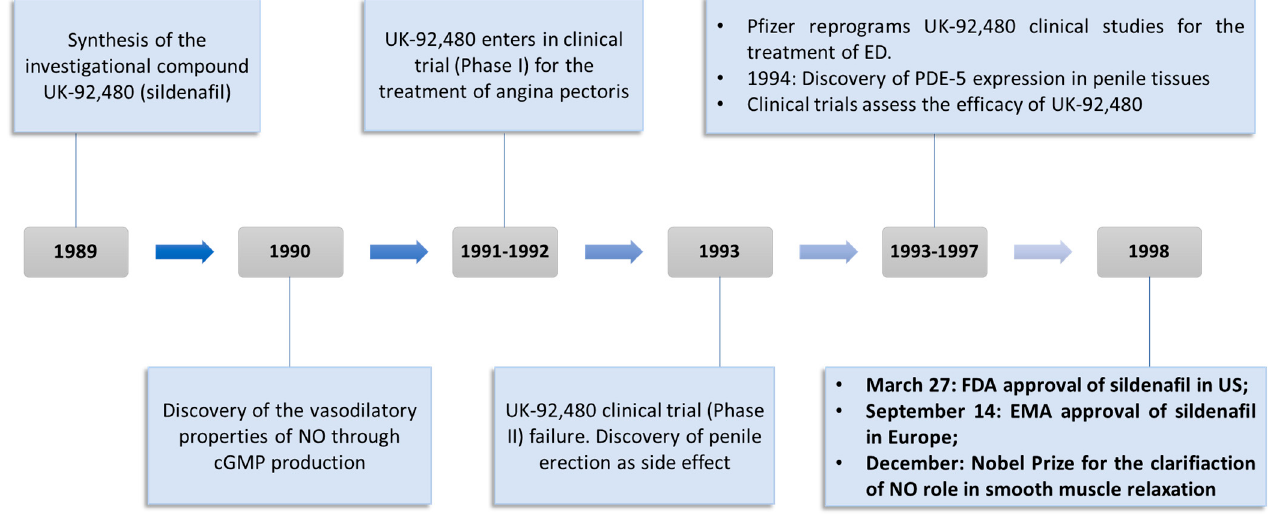
Figure 3. Timeline and milestones of sildenafil drug discovery.